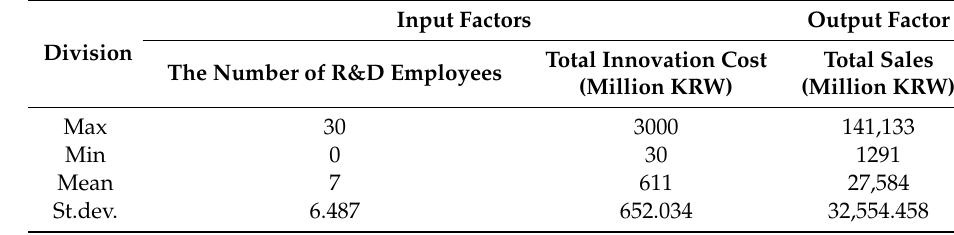
Table 3. Descriptive